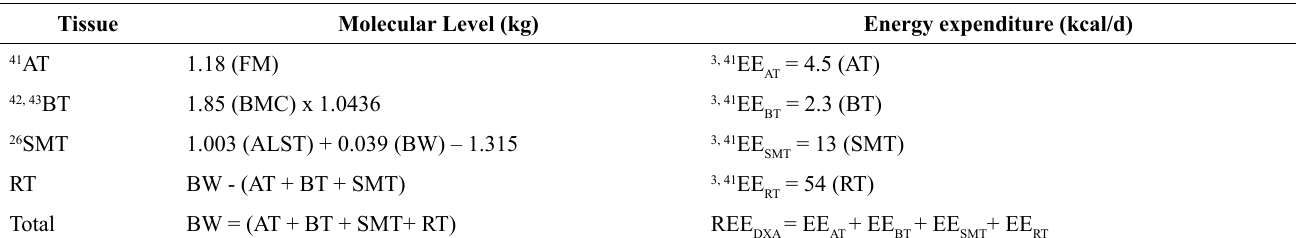
Table 1. Transformation of components measured by DXA from the molecular level to the organ-tissue level and specific energy expenditure of each component (References in